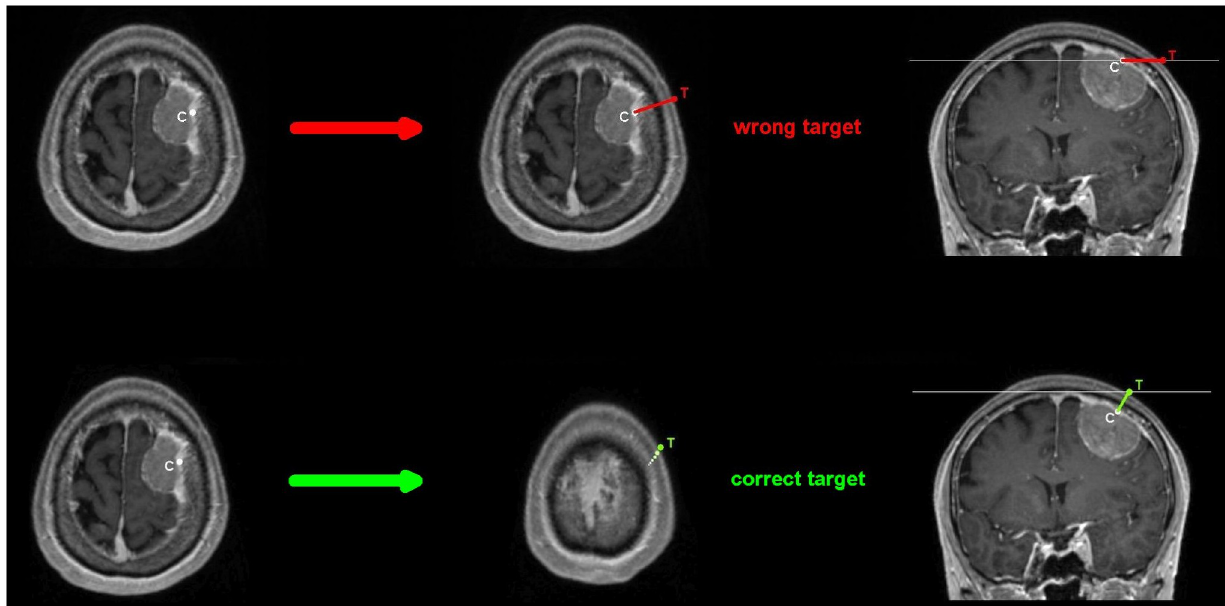
Fig 10. Top . A common error occurs when the target on the skin surface is chosen from a single plan, here axial orientation. This approach leads to a wrong center of the craniotomy for the respective lesion. Bottom . A corrective approach is to move and scroll with respect to the slice thickness to obtain an oblique